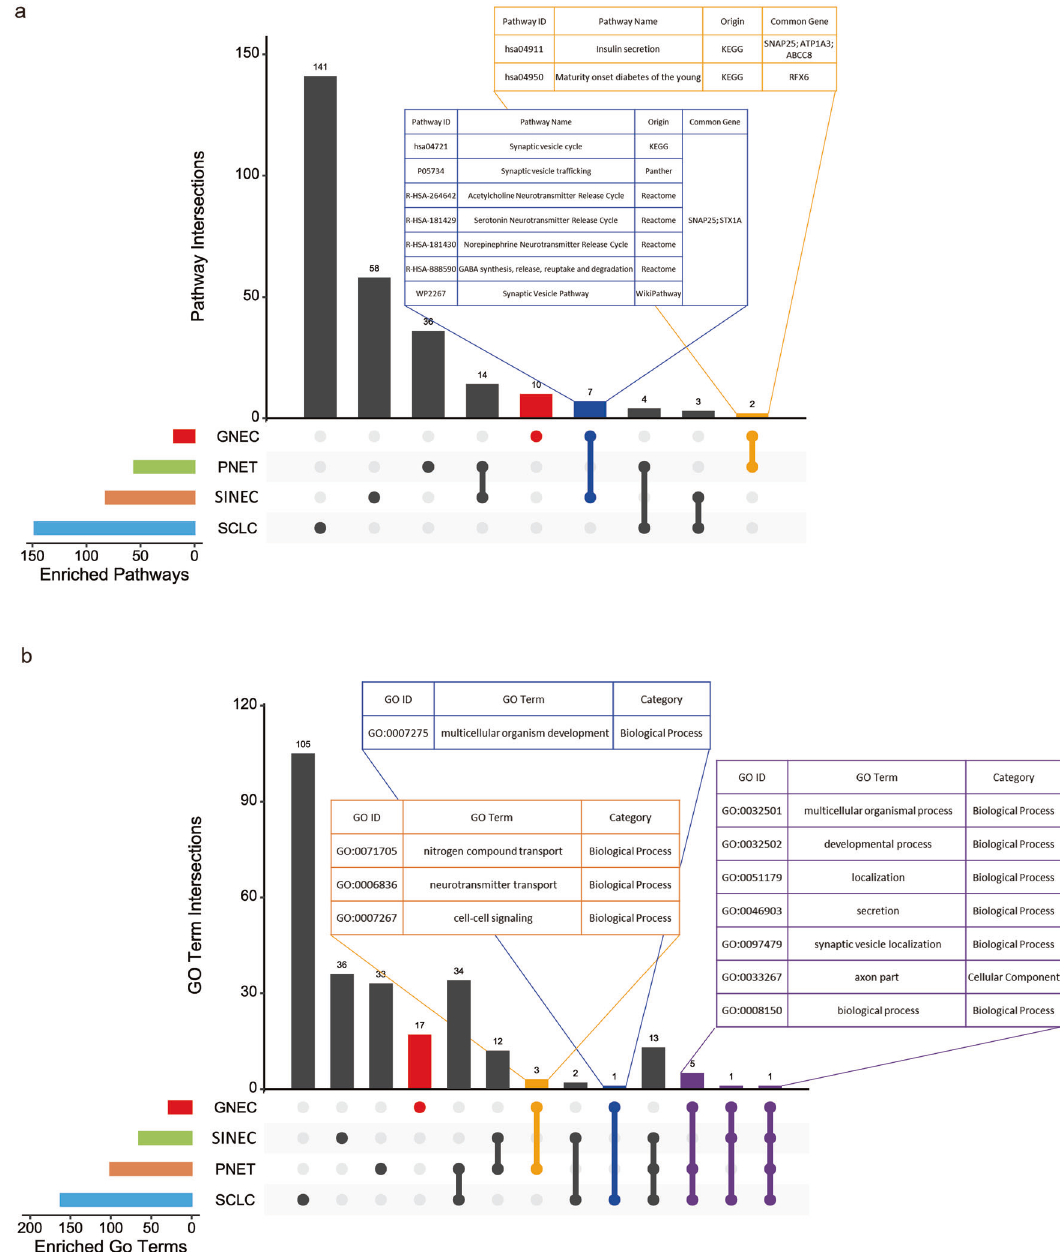
Fig. 6 Functional enrichment pattern comparison among GNEC, PNET, SCLC and SINEC. a The enriched pathways from overrepresentative analyses across different cancers were processed using UpSetR plot. The connected dots indicate which cancers were assessed. The pathways found in GNEC are highlighted. b The enriched GO terms from overrepresentative analyses across different cancers were processed using UpSetR plot. The connected dots indicate which cancers were assessed. The GO terms found in GNEC are